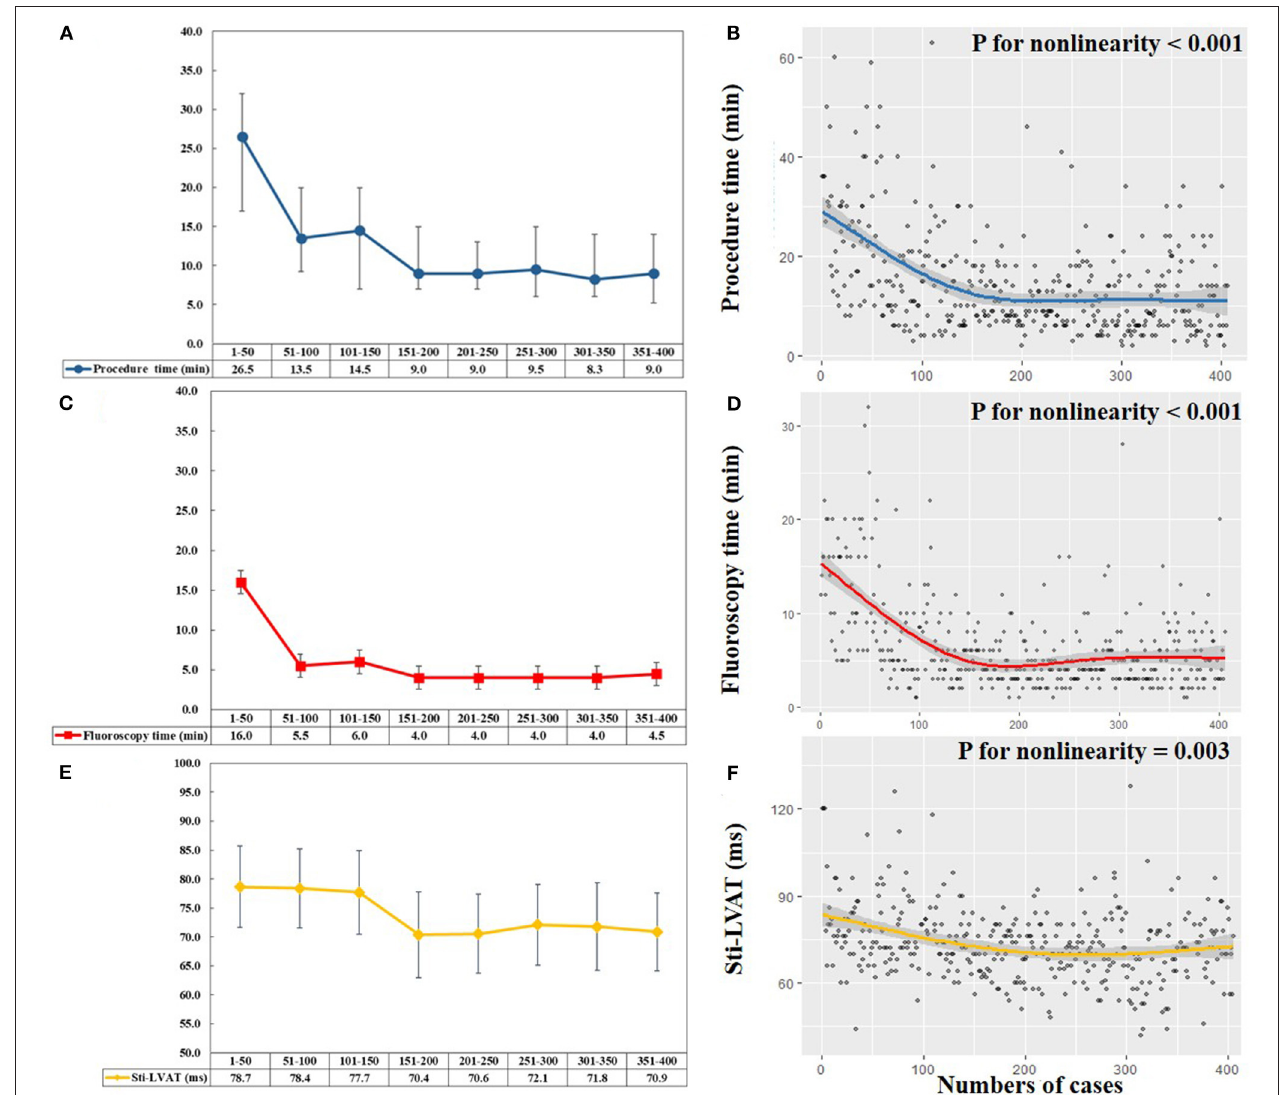
FIGURE 1 | Learning curves of left bundle branch area pacing (LBBAP). (A,C) Median procedure time (blue line) and fluoroscopy time (red line) of per 50 consecutive patients attempting LBBAP. ( B,D) Scatterplots and predicted learning curves of LBBAP indicated by procedure time (blue line) and fluoroscopy time (red line). The curves rapidly decreased until the 150th procedure and then reached a plateau, with the procedure time of 9min and fluoroscopy time of 5min (both P for nonlinearity < 0.001). ( E) Mean Sti-LVAT (yellow line) at the high output (5 V/0.4ms) of per 50 consecutive patients attempting LBBAP. ( F) Scatterplot and predicted learning curve of LBBAP indicated by Sti-LVAT (yellow line). The curve plateaued after approximately 200 procedures ( P for nonlinearity = 0.003). Sti-LVAT, Stimulus to left ventricular activation time.